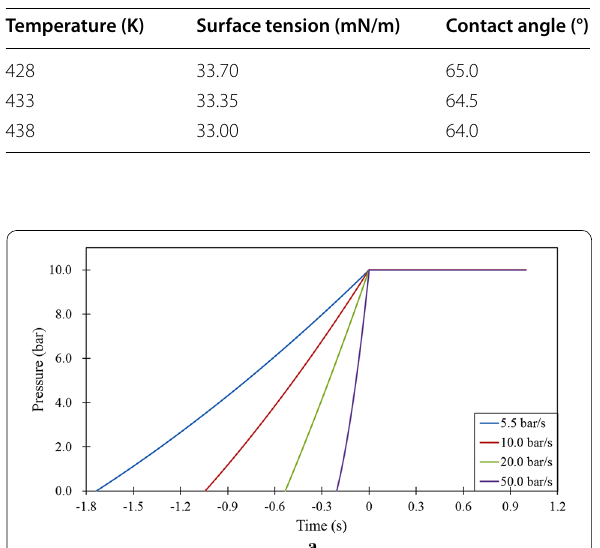
Table 2 Surface tension and contact angle according to the temperature